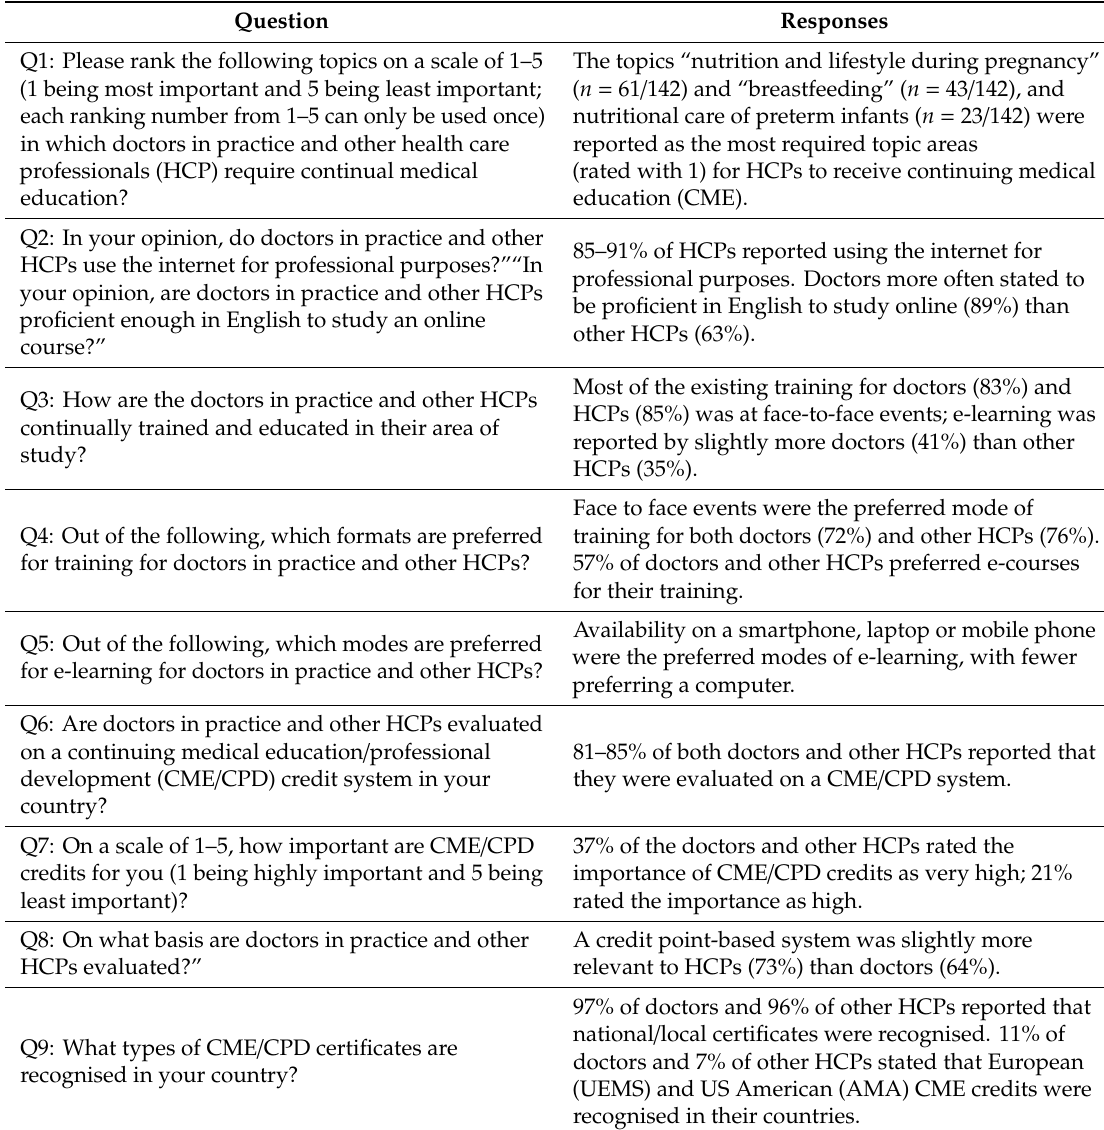
Table 1. Questions and participant responses: closed online questionnaire to health care professionals